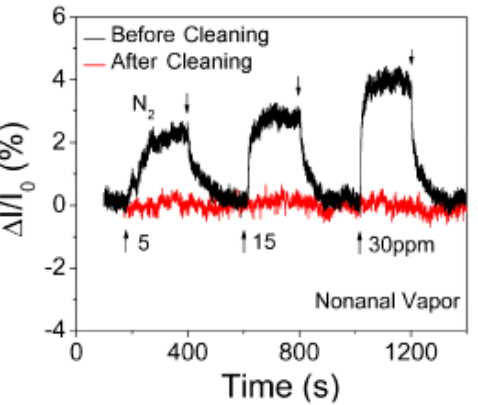
Figure 12. Measured sensor responses, before (black) and after (red) sample cleaning, to vapors of octanoic acid [75].